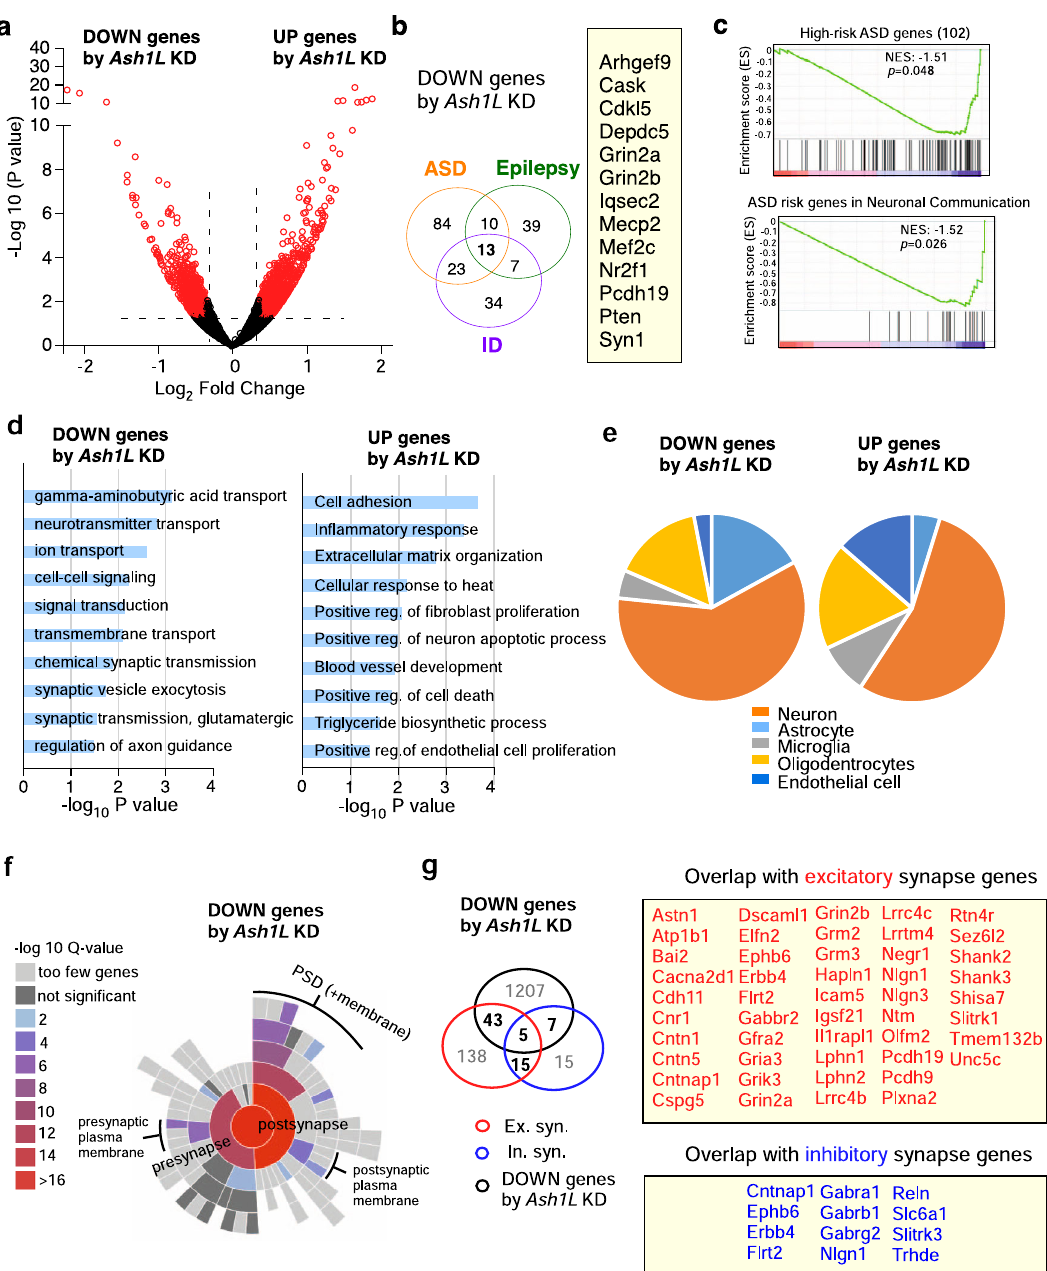
Fig. 2 Genes downregulated by Ash1L de fi ciency in PFC overlap with risk factors for ASD, epilepsy, and ID, and are enriched in the regulation of synaptic homeostasis. a Volcano plot showing differentially expressed genes (DEGs) in PFC infected with Ash1L shRNA AAV, compared to scrambled shRNA AAV. b Venn diagram showing the overlapping of downregulated (DOWN) genes by Ash1L de fi ciency with the risk genes for ASD, epilepsy, and ID. Inset: the list of DOWN genes commonly occurring in all the three disorders. c Gene set enrichment analysis (GSEA) of the correlation between the DOWN genes by Ash1L de fi ciency and the 102 top-ranking ASD risk genes (top) or the top ASD risk genes involved in neuronal communication (bottom). d Gene Ontology analysis of downregulated or upregulated genes by Ash1L de fi ciency. e Pie chart showing the cell type distribution of Ash1L de fi ciency- induced DEG expression. f Sunburst plot representing cellular component enrichment analysis of downregulated synaptic genes by Ash1L de fi ciency. Higher red intensities are associated with more signi fi cant enrichments. All the identi fi ed synaptic genes are represented in the red circle at the center of the plot. g Venn diagram showing the overlapping of DOWN genes by Ash1L de fi ciency and genes at excitatory or inhibitory synapses. Inset: the list of downregulated synaptic